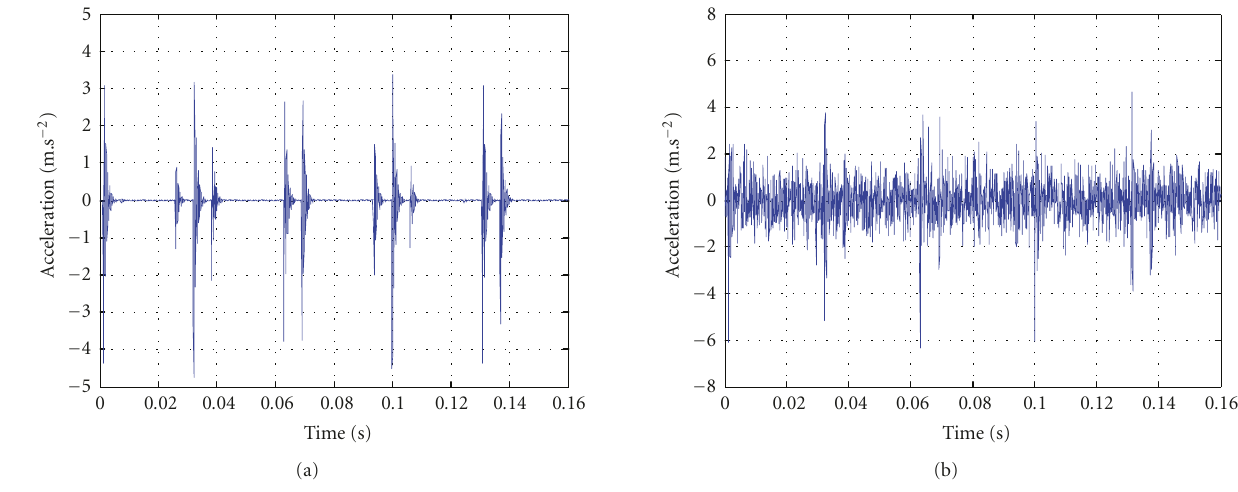
Figure 2: The simulated impulses (a) and the vibration signal (b) for a rolling bearing with inner-race fault.